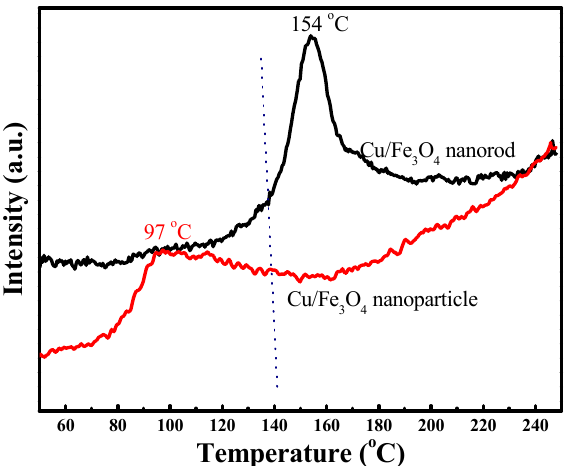
Figure 5. Temperature-programmed-reduction of oxidized surfaces (s-TPR) profiles of Cu/Fe 3 O 4 nanoparticle and Cu/Fe 3 O 4 nanorod.